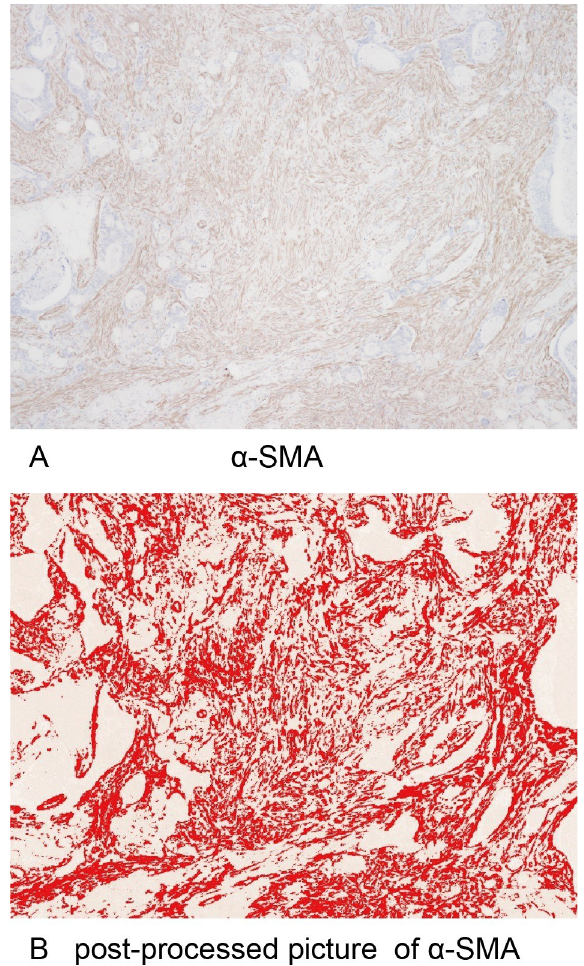
Fig 1. Original and post-processed images of α -SMA-positive cancer-associated fibroblasts. (A) α -SMA-positive cancer-associated fibroblasts at x40 HPF. (B) A post-processed image in which the brown area of α -SMA-positive cancer-associated fibroblasts was changed to a red color using